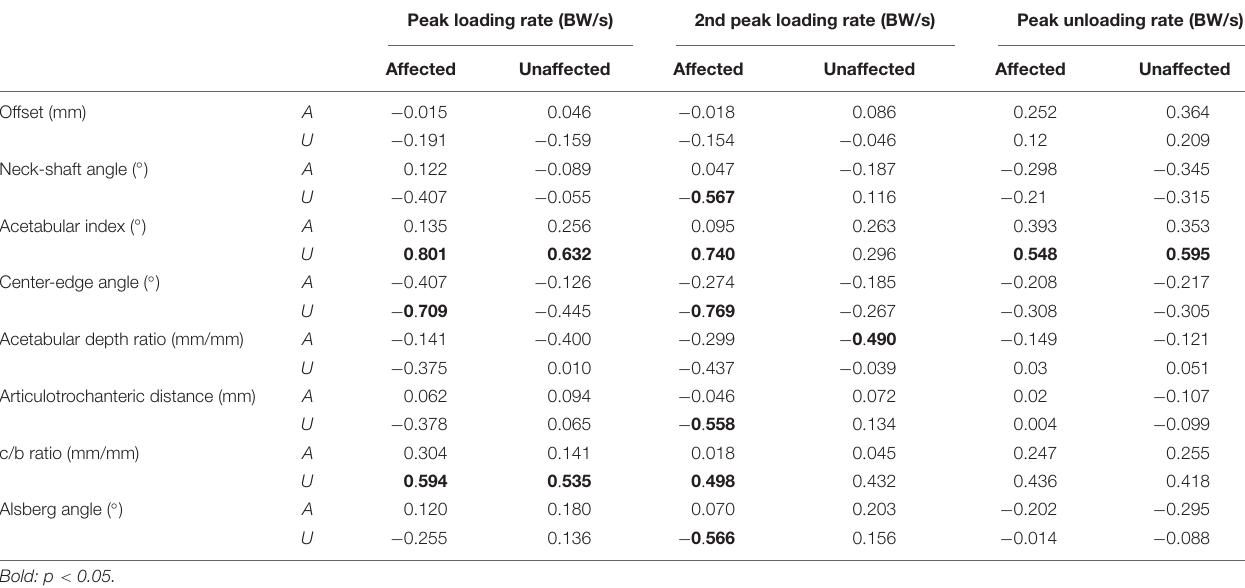
TABLE 4 | Correlations between loading and unloading rates of vertical ground reaction force and radiographic measurements of both affected (A) and unaffected (U) sides.